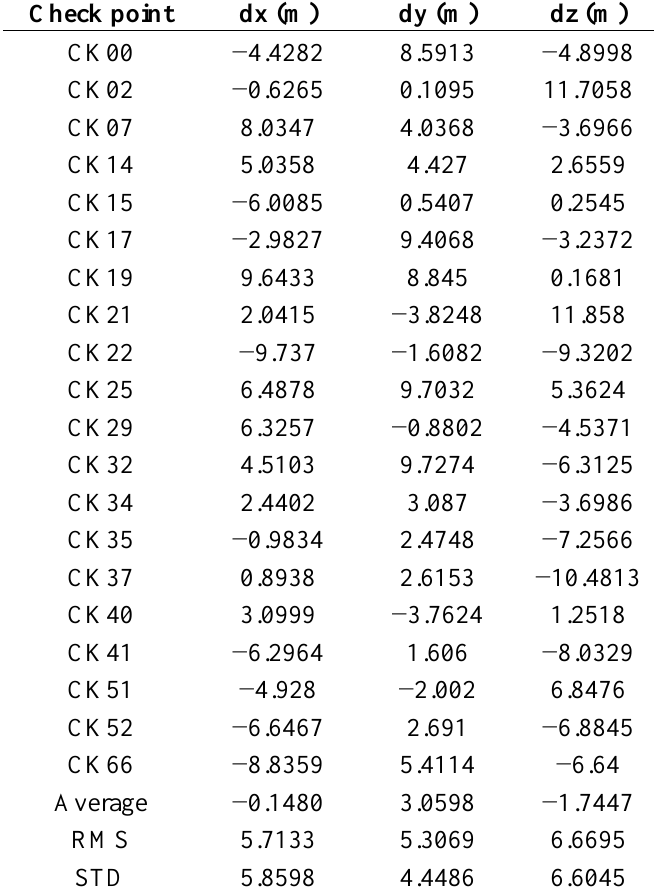
Table 6. Results of DG